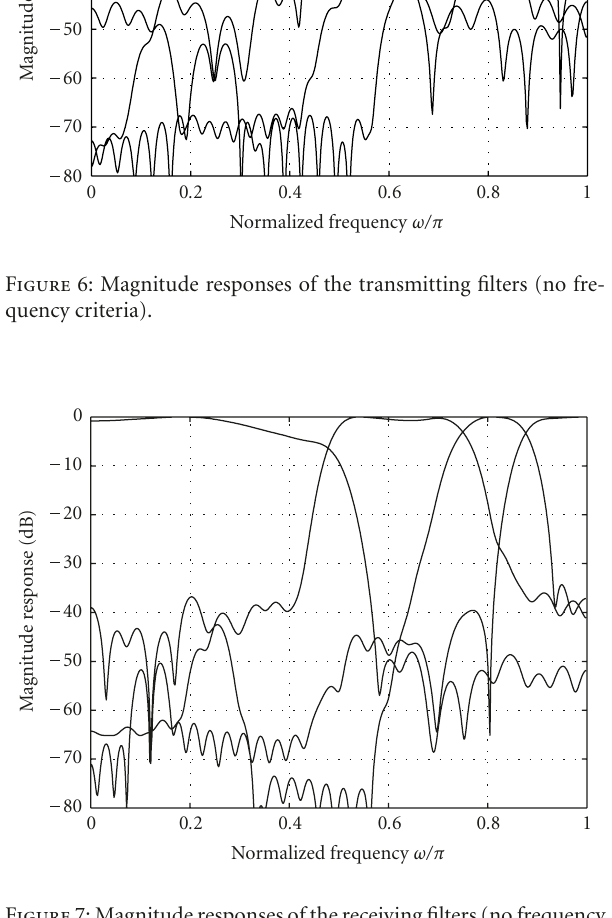
Figure 9: Magnitude responses of the transmitting filters (with fre- quency